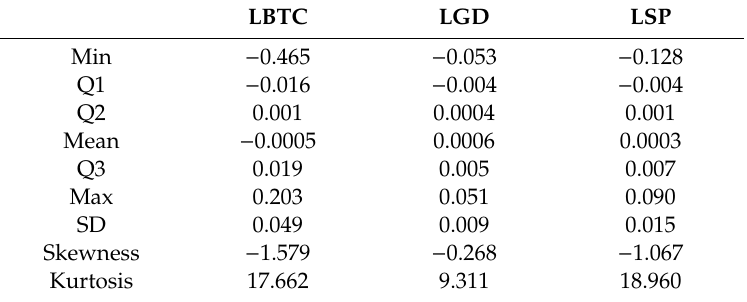
Table2. Summarystatisticsofthelog-returnofBitcoin(LBTC),log-returnofGold(LGD),andlog-returns of S&P 500 (LSP).